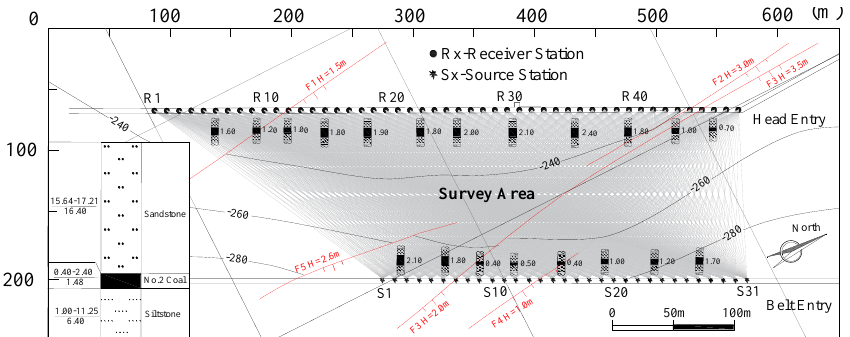
Figure 2. The geological map of the survey area and the ray coverage map combined with realized survey geometry (location of all source and receiver stations).